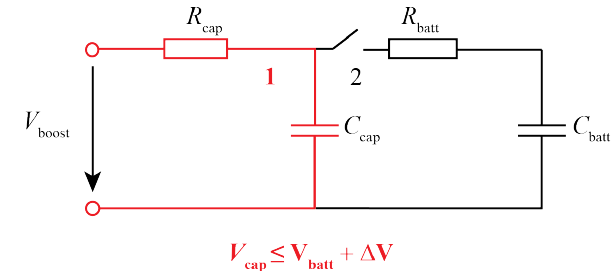
Figure 7. Geometry and orientation of the rotational mass. Figure 5. Initial state of the battery charging